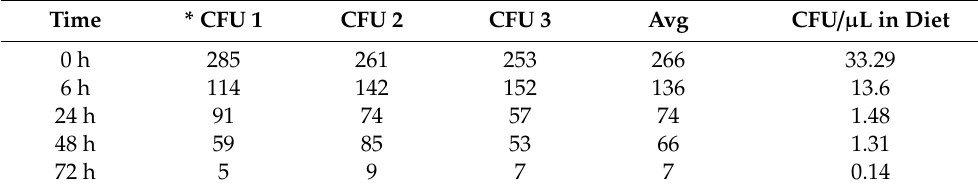
Table 2. M. plutonius strain AF5 decreases in the in vitro larval rearing